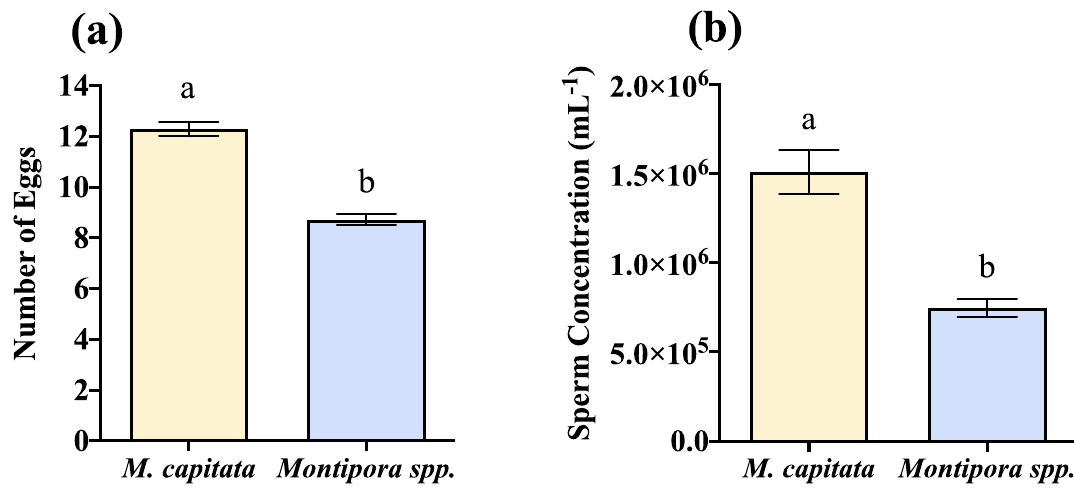
Figure 2. Eggs and sperm per bundle. ( a ) The mean number eggs per bundle is greater in Montipora capitata than Montipora spp . (n = 156 M . capitata , n = 156 Montipora spp ., p < 0.0001, Welch’s t = 9.979). ( b ) Mean sperm concentration per mL per bundle is also greater in Montipora capitata than Montipora spp . (n = 142 M . capitata , n = 142 Montipora spp ., p < 0.0001, t = 5.45). Error bars are SEM, and different letters above error bars indicate significant difference. (GraphPad Prism 9 v. 9.0.1; San Diego, CA, USA, www. graph pad.